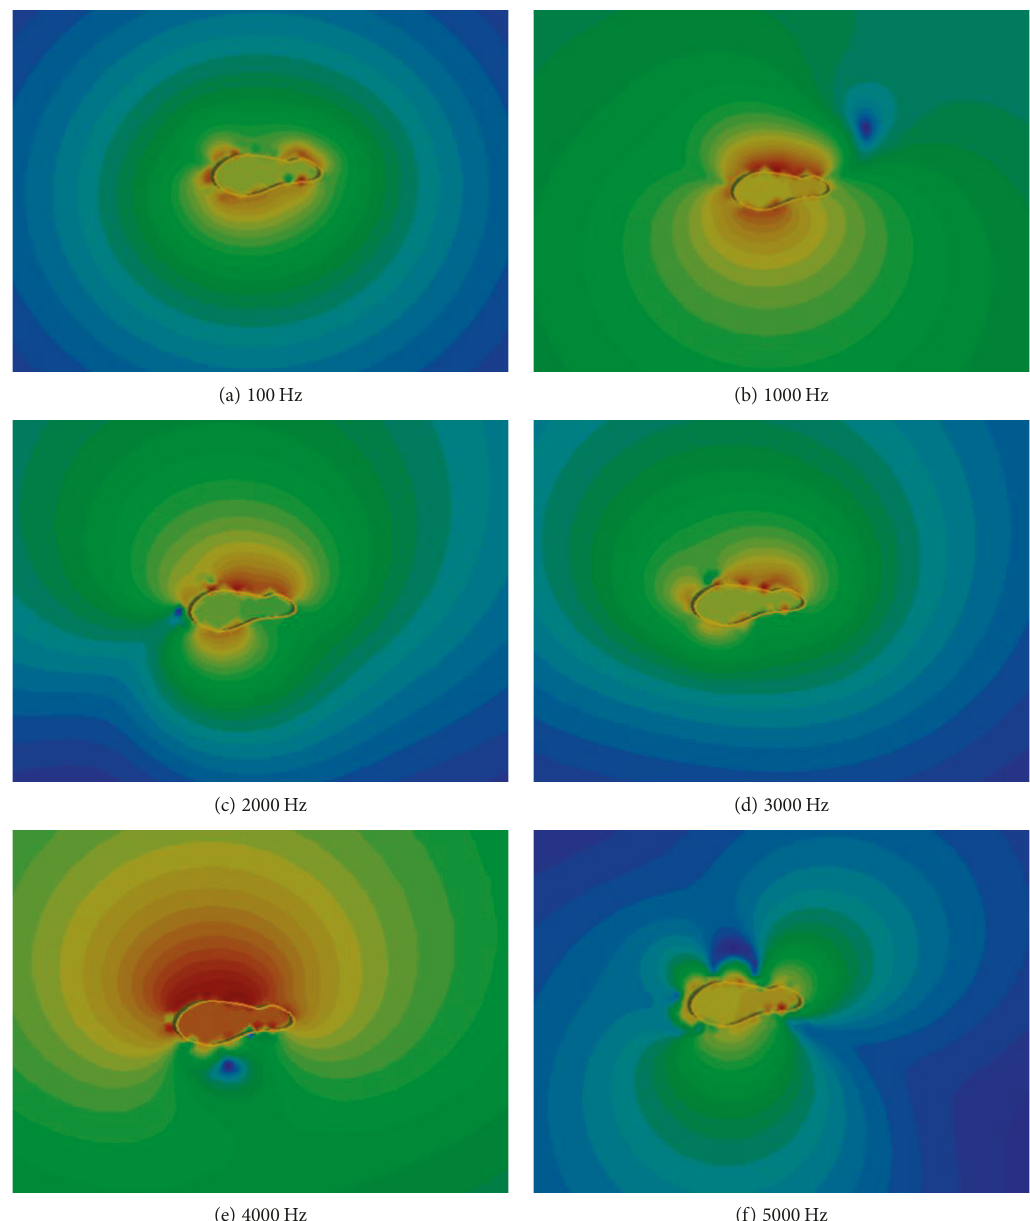
Figure 6: Contour of radiation noise of asymmetric cross-section rod.